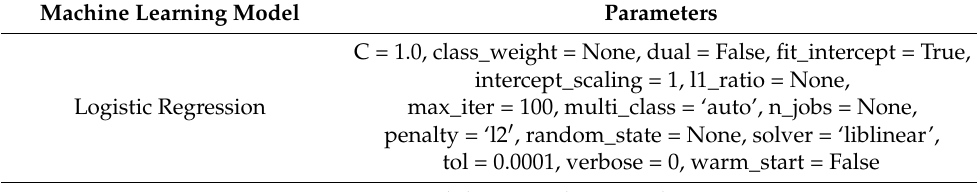
Table A1. The machine learning models and the corresponding parameter values applied in the context of this